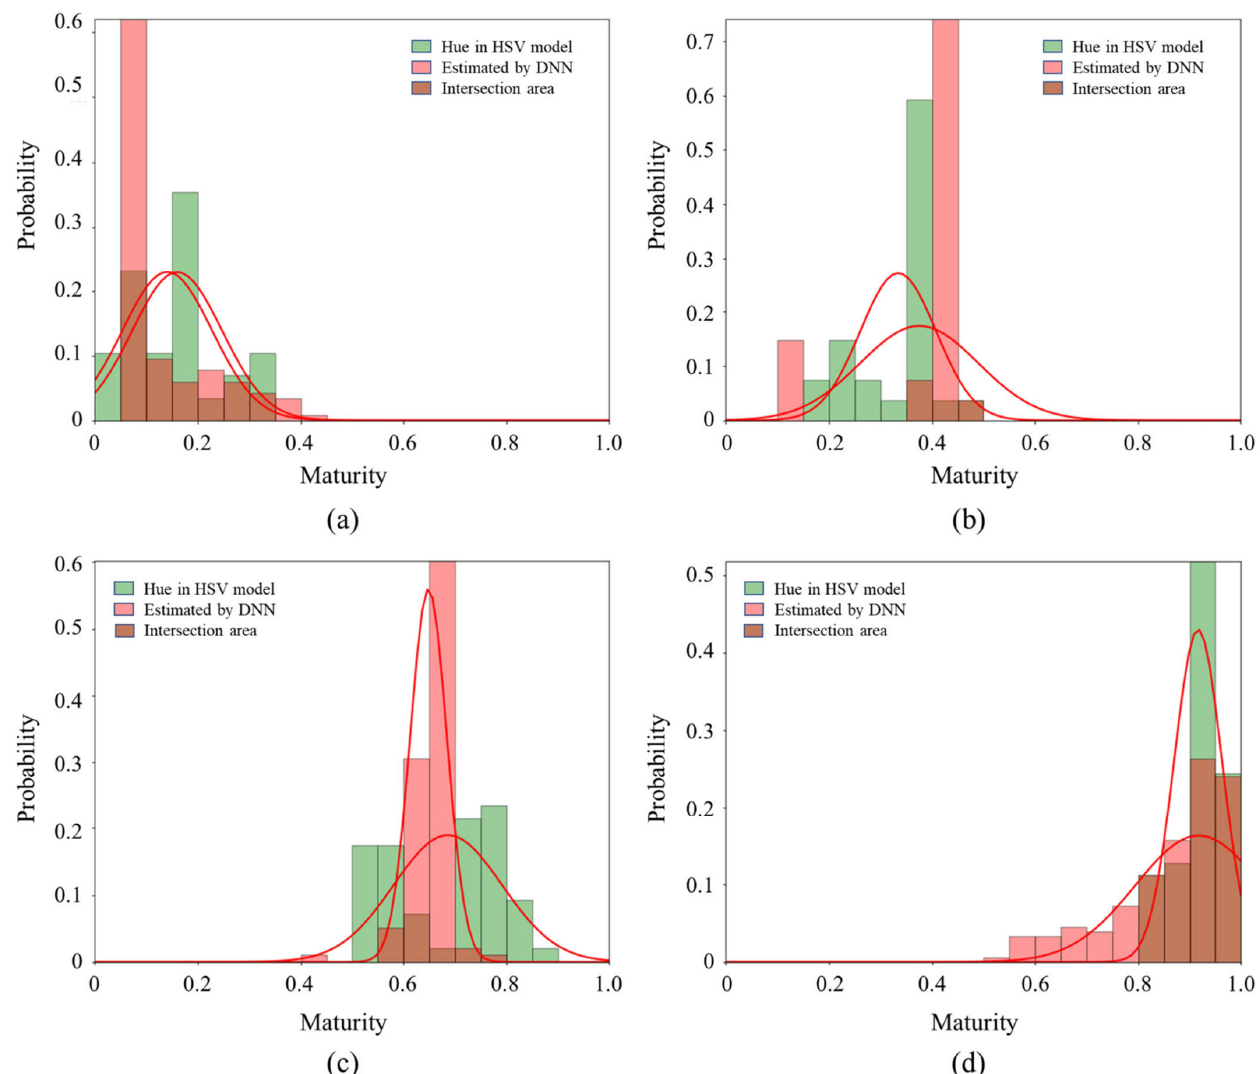
Figure 7. Comparisons of histograms and fitted Gaussian distributions between the estimated maturity and hue value from tomato images: ( a ) green, ( b ) turning, ( c ) pink, and ( d ) red.